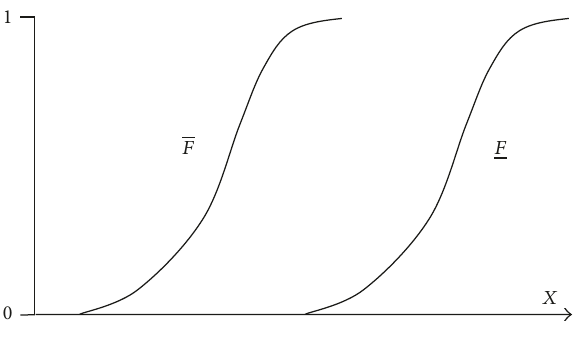
Figure 17: P-box model.